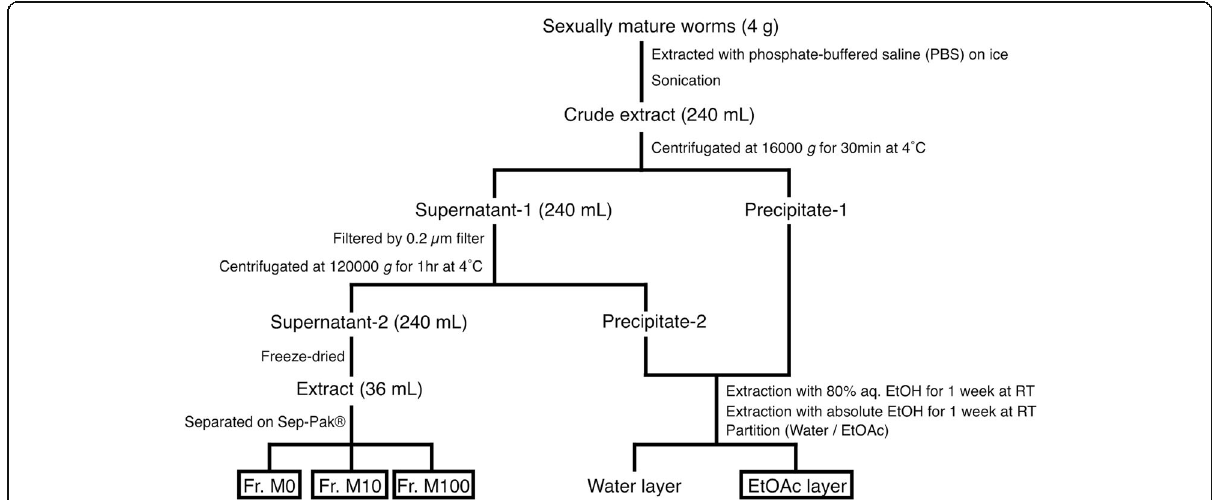
Fig. 2 Procedure for the fractionation of sexually mature worms. See the text for experimental details. Fr., fraction. Three fractions and a layer used for the bioassay are highlighted in the